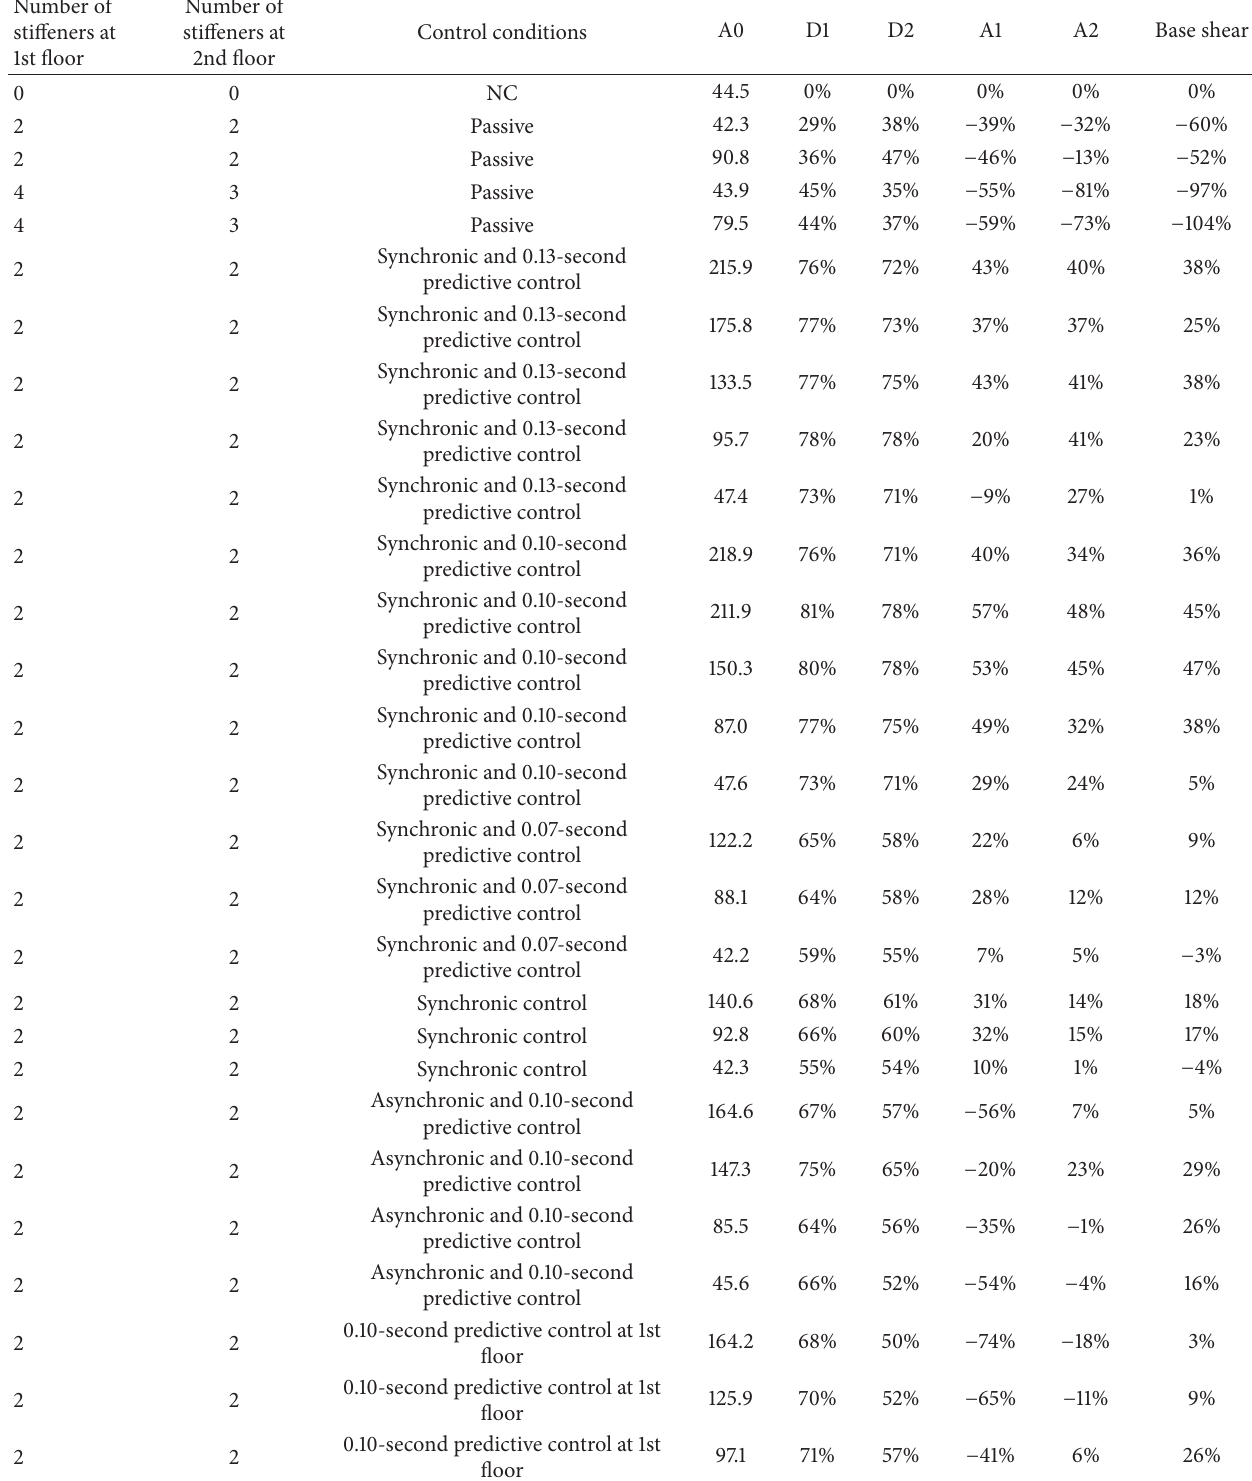
Table 4: The ratios of maximum shock absorption of test structure under excitation of El Centro earthquake record with various control conditions and different peak ground